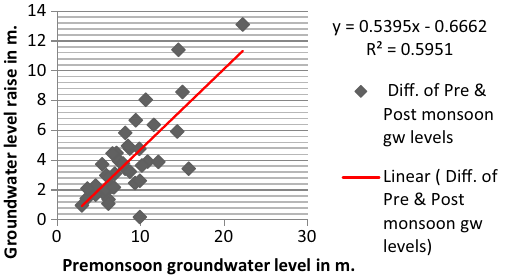
Fig. 7 Relation between pre-monsoon groundwater levels and the dif- ference of pre- and post-groundwater levels in m of 2014